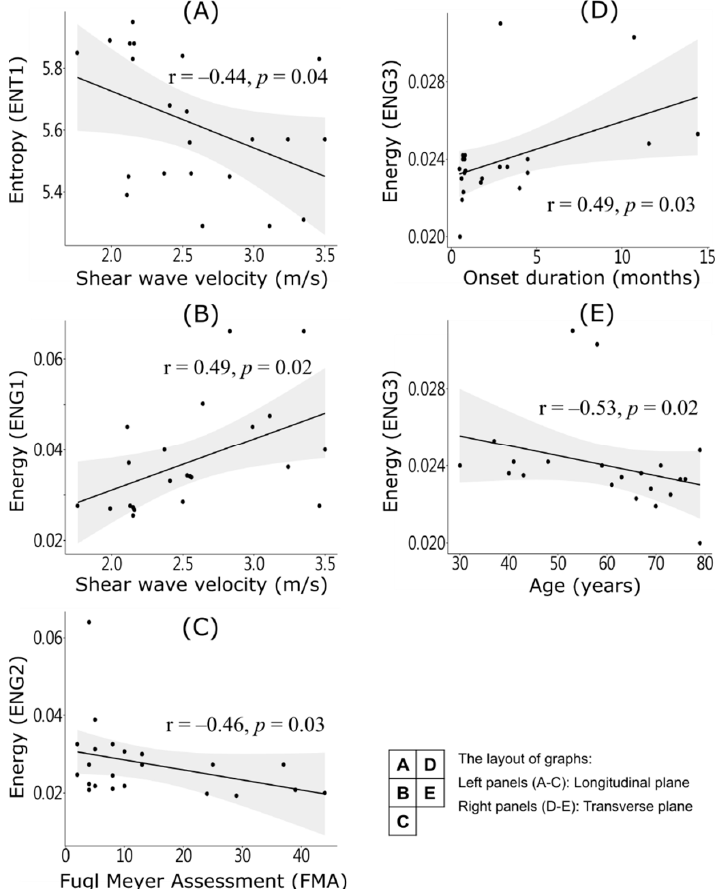
Figure 5. Relationships between muscle stiffness, echotexture features, functional performance, age and onset duration in the longitudinal plane (left panels: A - C) and transverse plane (right panels: D - E).